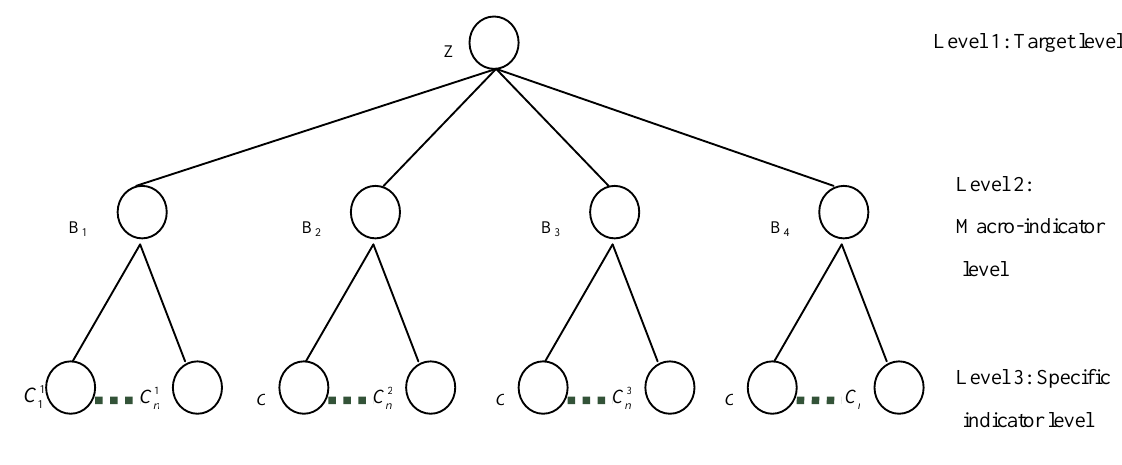
Figure 2. Grey hierarchy system used for indicator selection.